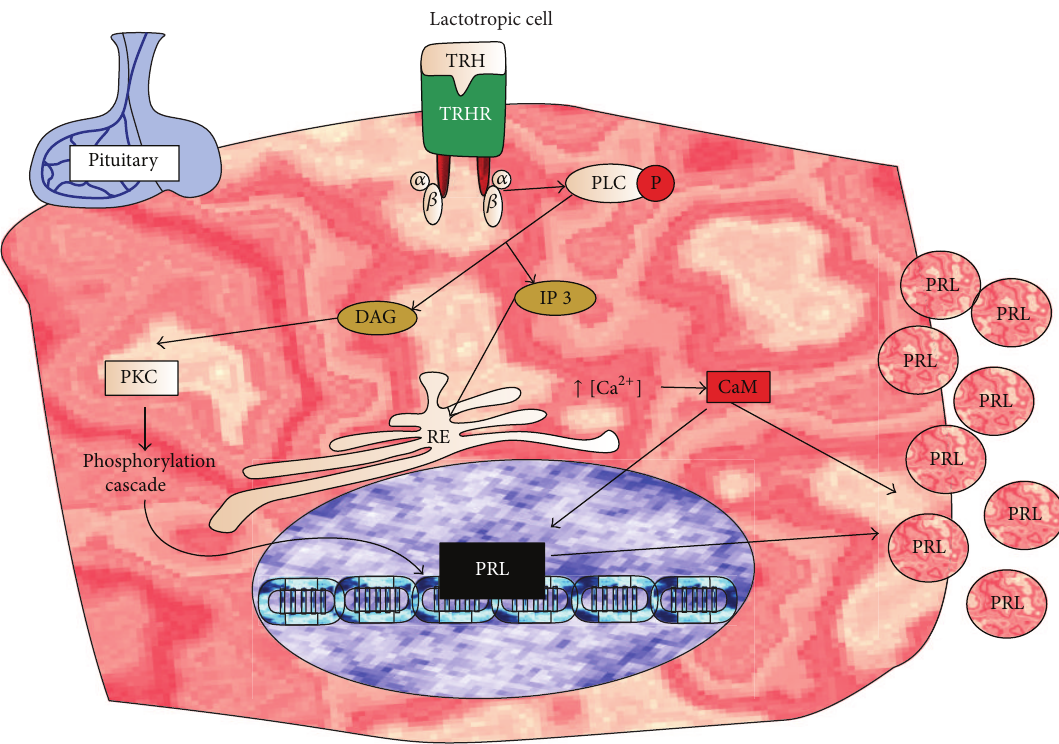
Figure 5: Proposed mechanism of action of thyrotropin releasing hormone (TRH). The TRH molecule binds to its receptor in lactotrophic cellsofthepituitaryglandandstimulatesCa 2+ /CaMrelease,whichinducesthePRLgeneexpression.Furthermore,theincreaseinintracellular CA 2+ /CaM stimulates the release of PRL stored in vesicles. This will increase PRL blood levels and promotes more milk